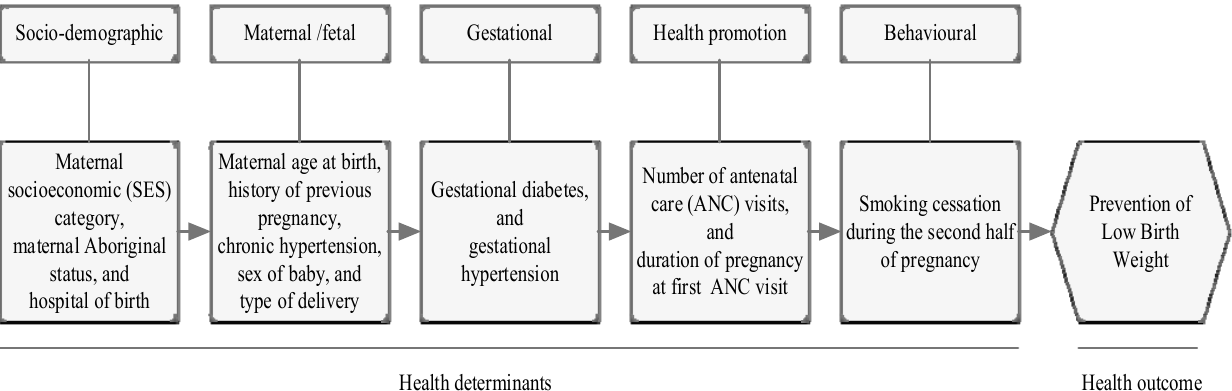
Figure 1. Conceptual framework for the analysis of smoking cessation during the second half of pregnancy and low birth weight (LBW) of babies among mothers of reproductive age (15–49 years).